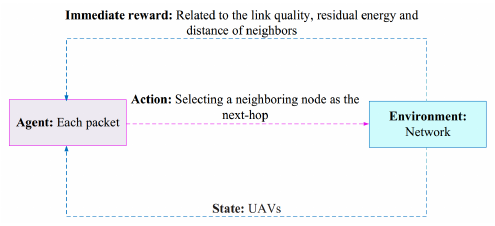
Figure 40. Learning process in TARRAQ. Table 22. The most important advantages and disadvantages of TARRAQ. Advantage